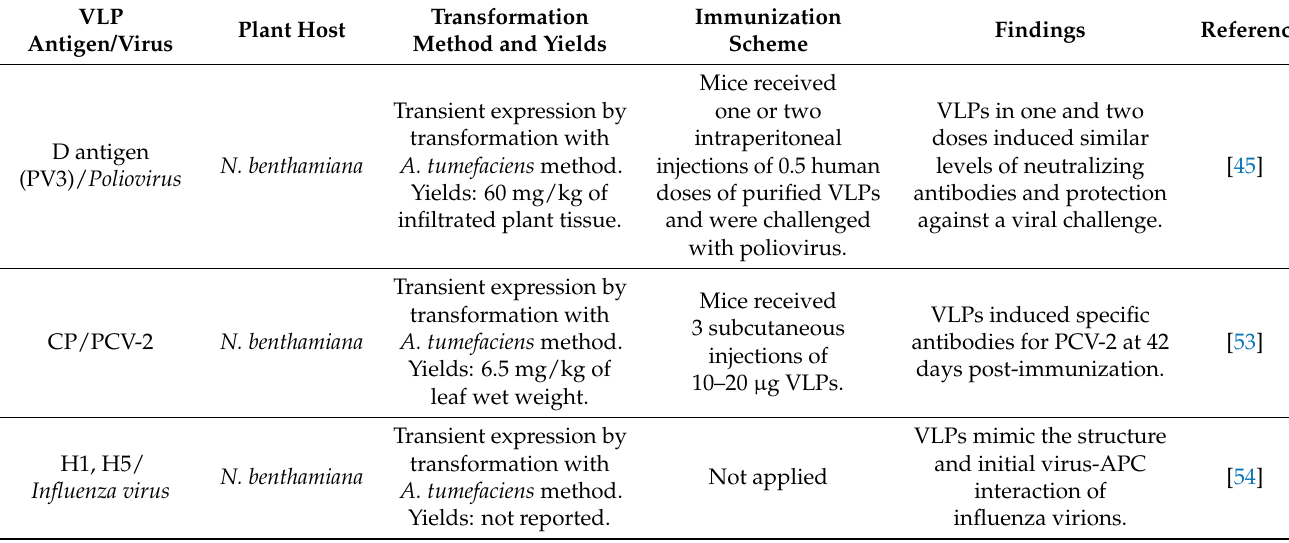
Table 2. Main antigens recently expressed as viral virus-like particles